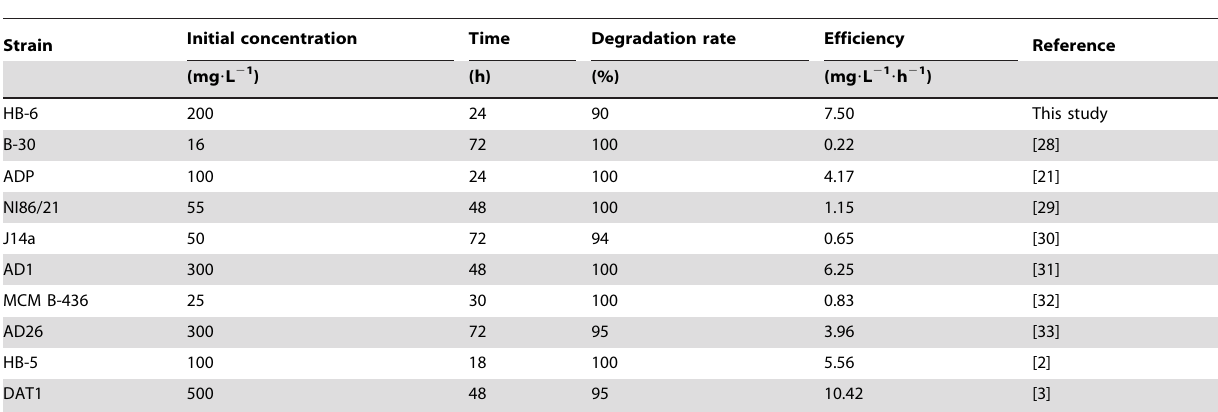
Table 1. Comparison of degradation efficiency of atrazine-degrading microorganisms.